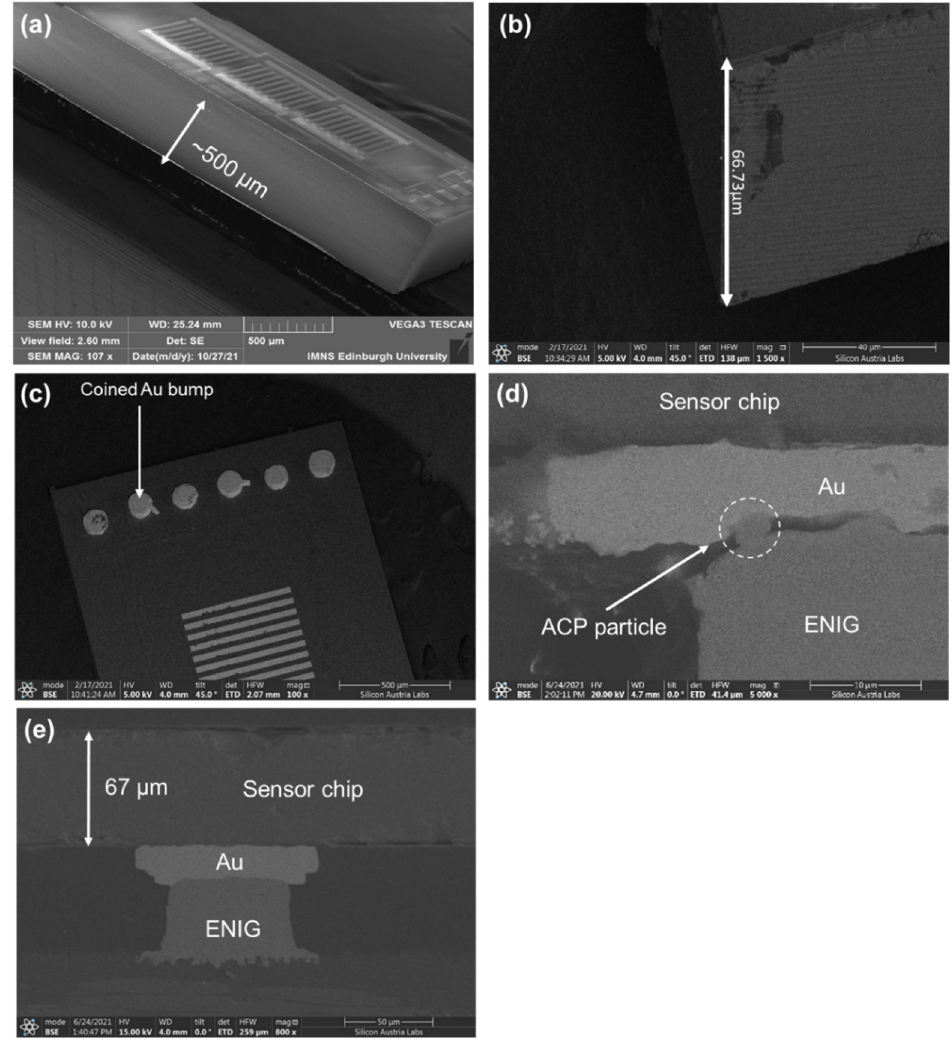
Figure 4. SEM images of the thinning and flip-chip integration of the sensor chip on flex, ( a ) thick sensor chip, ( b ) thinned sensor chip, ( c ) cocned Au bump on chip, ( d ) ACP flip-chip bonding, and ( e ) thermosonic flip-chip bonding on flex.